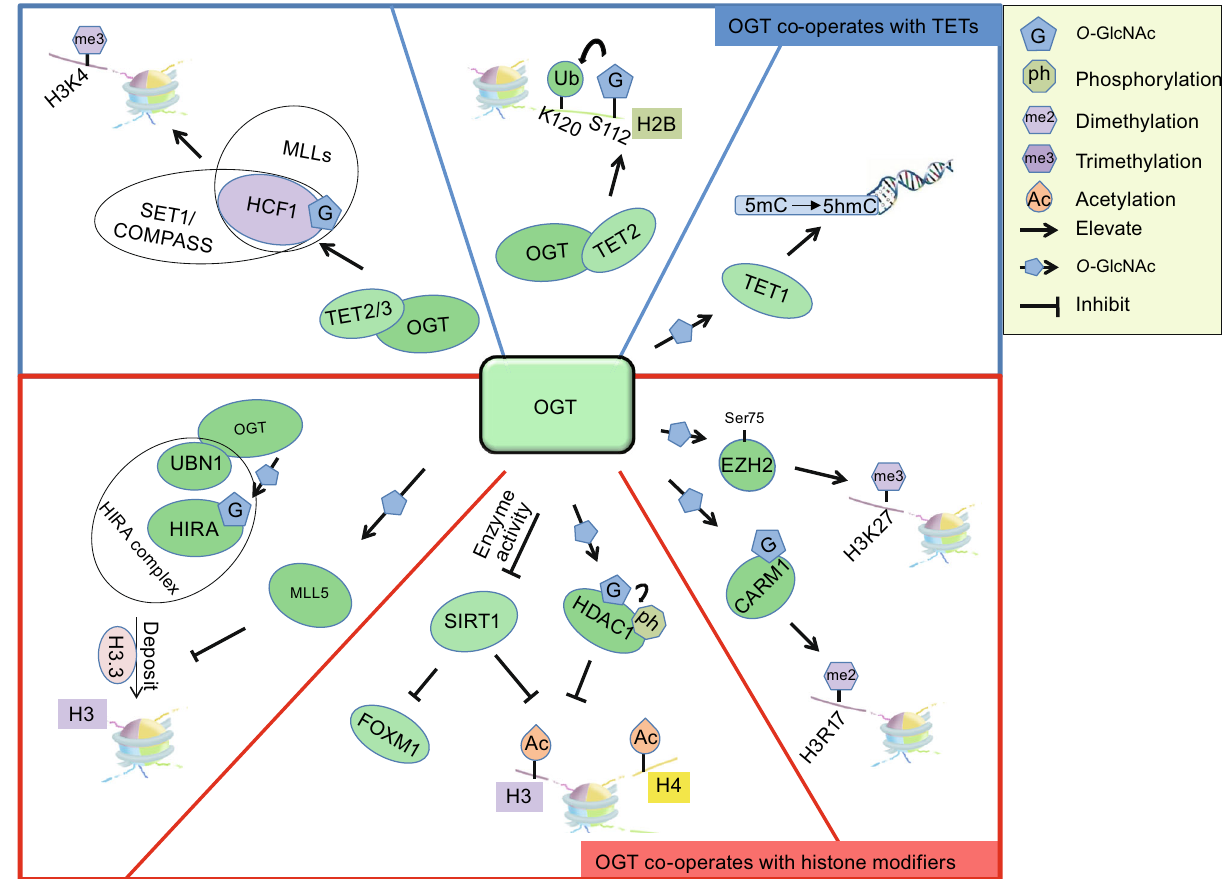
Figure 3. Crosstalk between O -GlcNAcylation and chromatin remodelers. Extensive connections of O -GlcNAcylation with chromatin modi fi ers are detected